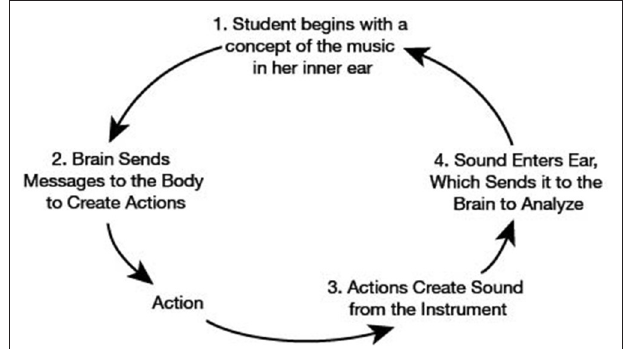
FIGURE 1 | Kreitman’s listening loop for performing correctly with good tonalization (redrawn from Kreitman, 2010, p.